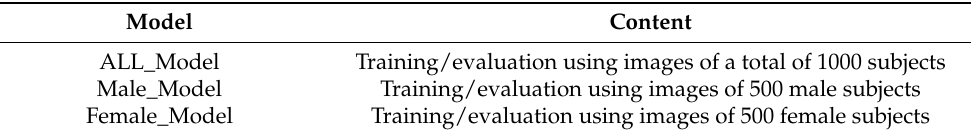
Figure 3. Images missing due to data augmentation. *: magnification factor. Table 2. Age estimation model.